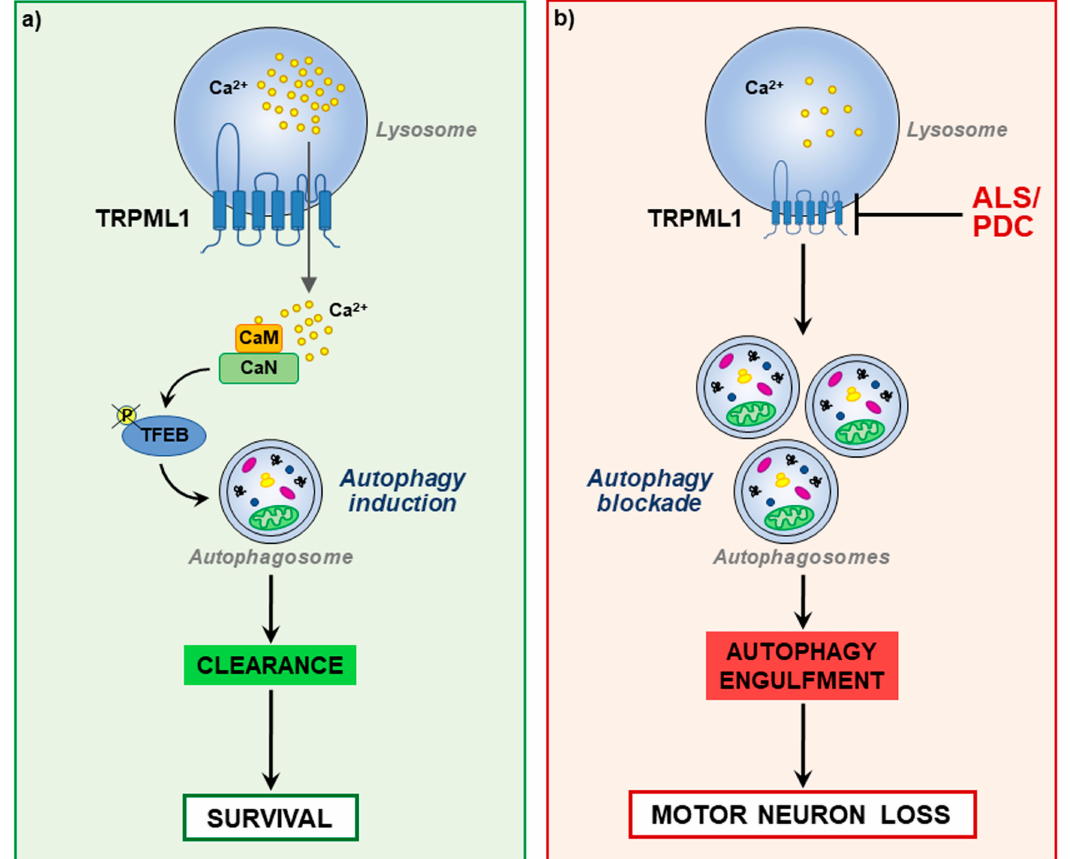
Figure 2. Representation of neuronal TRPML1 ( a ) under physiological conditions in which, after Ca 2 + release through the channel, a Ca 2 + -dependent activation of TFEB (Transcription factor EB) triggers autophagy thus promoting cell survival; ( b ) in an experimental model of ALS / PDC (Parkinsonism-dementiacomplex)inwhichthereductionofTRPML1expressionandactivitydetermines an engulfment of autophagy and motor neuron